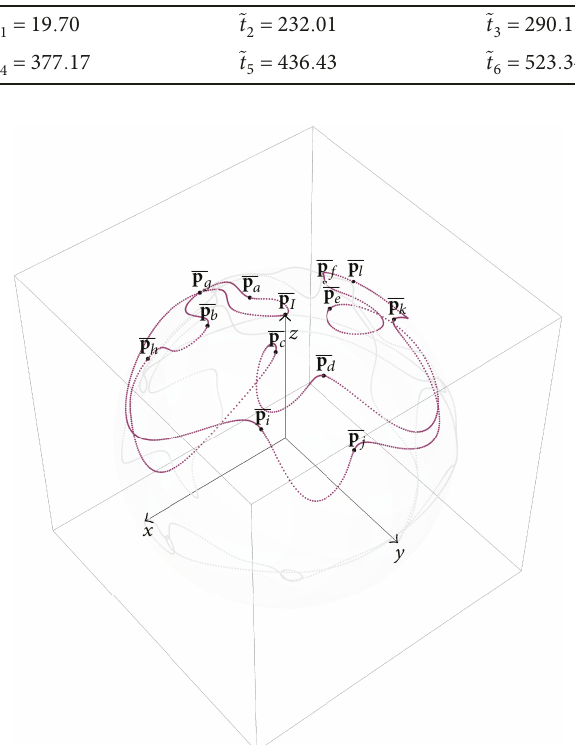
Table 2: Switching times expressed in [s] of the optimal solution of experiment A with 6 target attitudes.